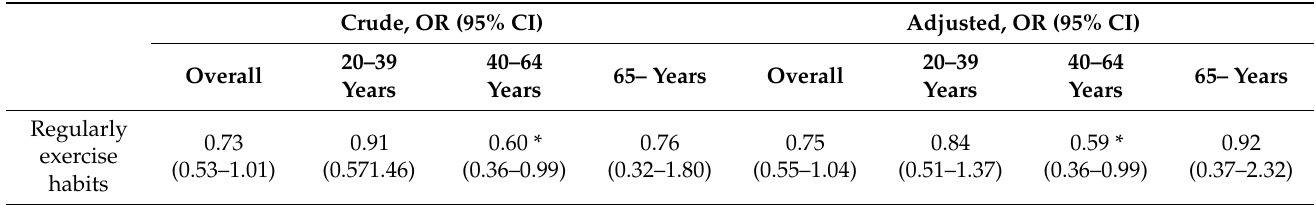
Table 4. Poor sleep quality and regularly exercise